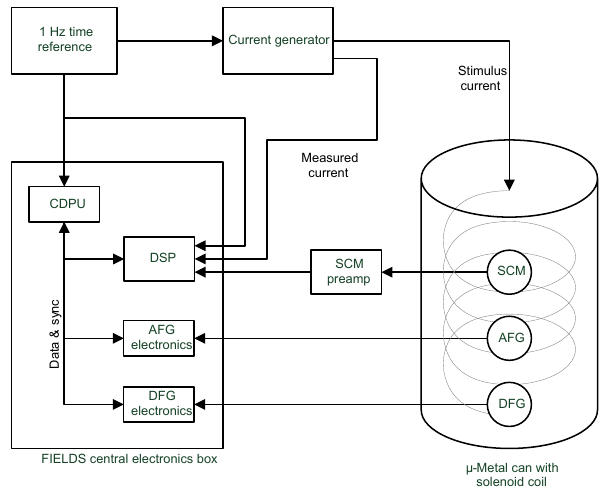
Figure 2. Test setup for instrument frequency response measure-